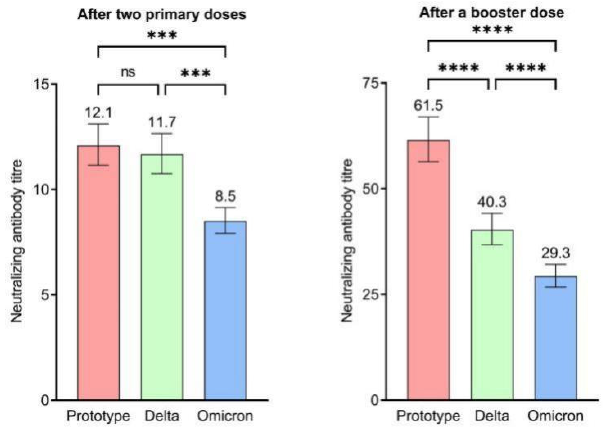
Figure 3. Neutralizing antibody titer against the SARS-CoV-2 wild-type strain, and Delta and Omicron variants after primary and booster immunizations (ns: not significant; ***: p < 0.001; ****: p < 0.0001).